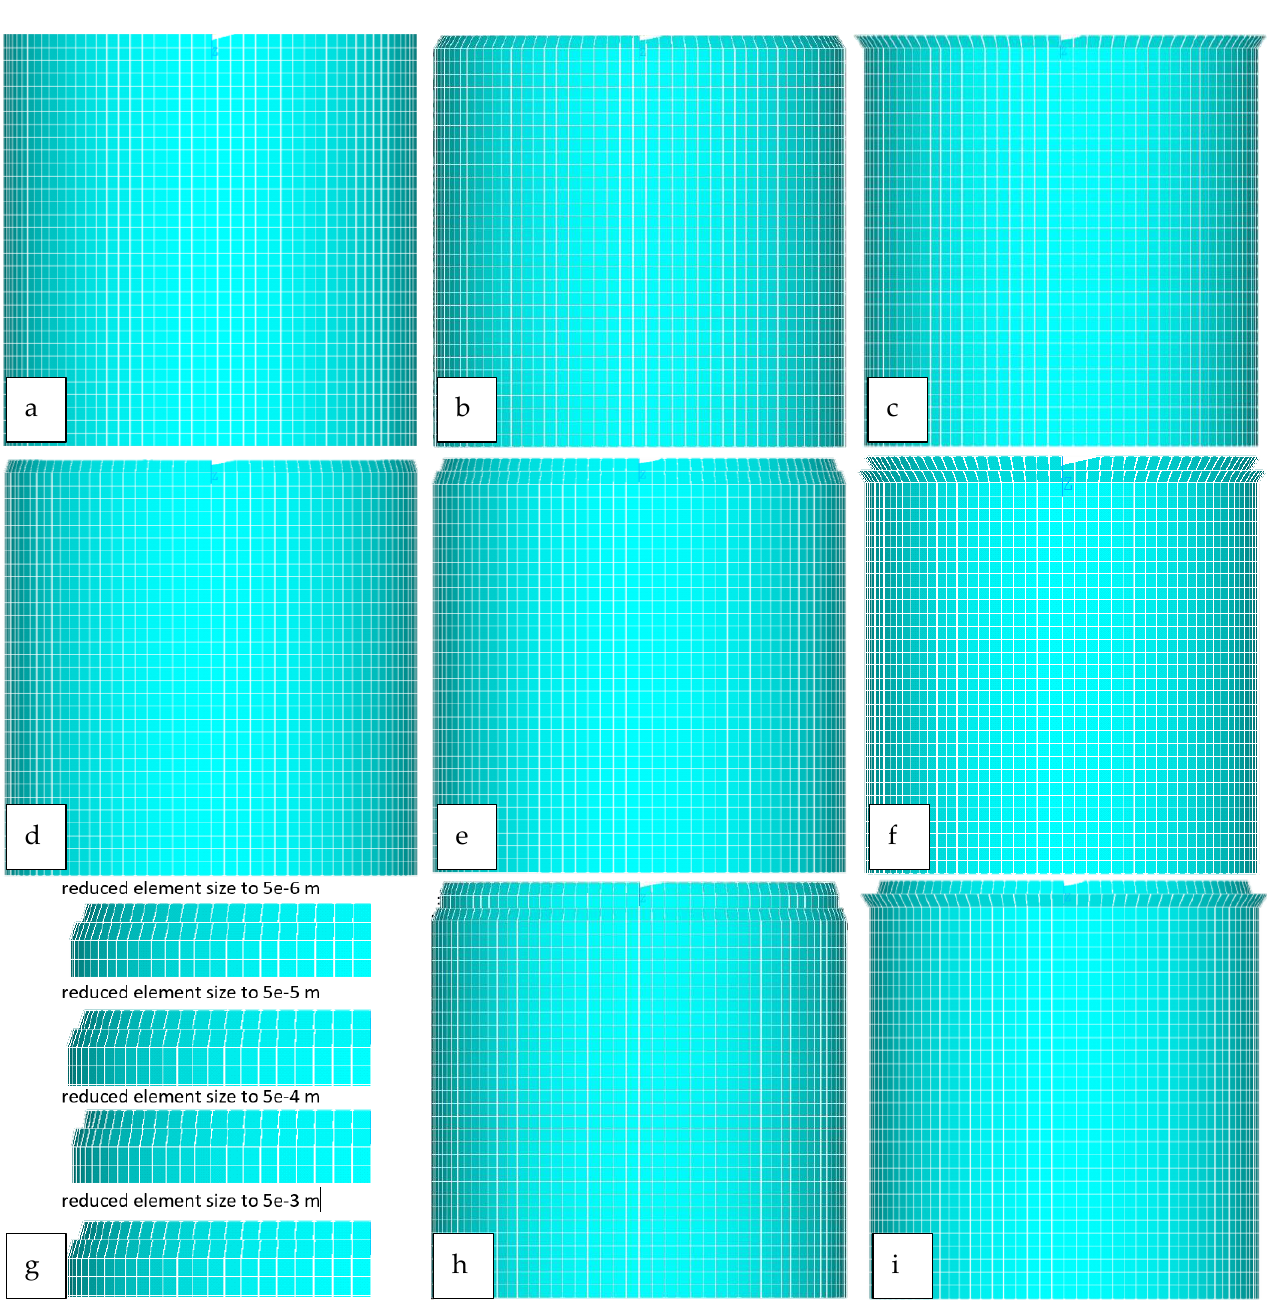
Figure 8. Trigger mechanism modelling cases, ( a ) single-shell no trigger, ( b ) single-shell inward-chamfer, ( c ) single-shell outward-chamfer, ( d ) double-shell level size inward-chamfer, ( e ) double-shell 2.5 mm shell size difference inward-chamfer, ( f ) double-shell 2.5 mm shell size difference outward- chamfer, ( g ) double-shell 2.5 mm shell size difference inward-chamfer different reduced element sizes, ( h) double-shell 5 mm shell size difference inward-chamfer, ( i ) double-shell 2.5 mm shell size difference inward and outward-chamfer